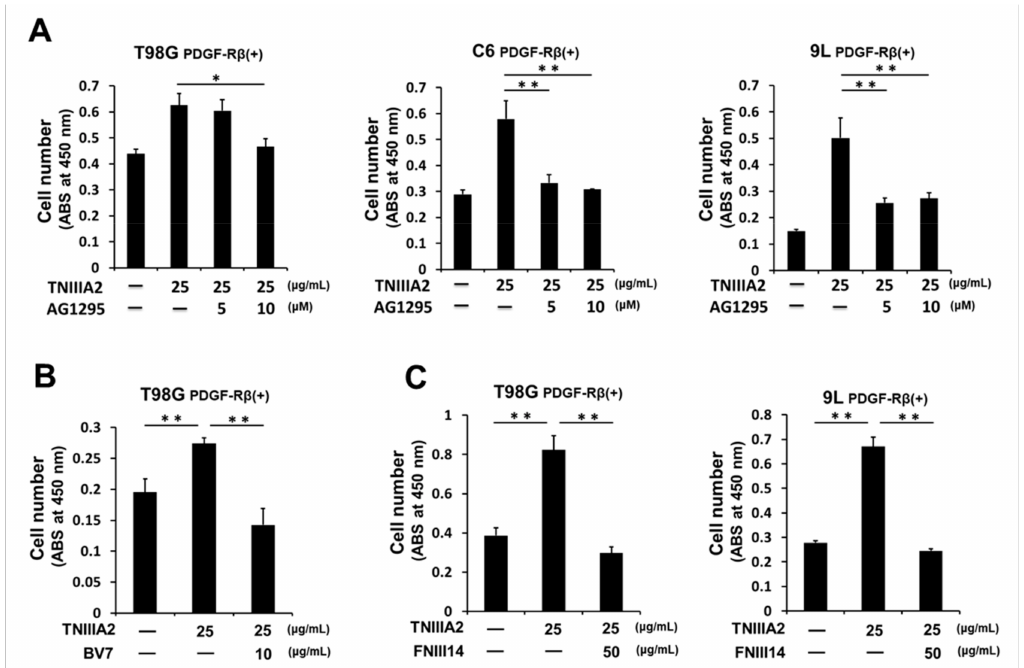
Figure 2. TNIIIA2 potentiates PDGF-dependent GBM cell proliferation through stimulation of PDGF-R tyrosine kinase activity by β 1-integrin activation. E ff ects of ( A ) AG1295, PDGF-R kinase inhibitor, ( B ) BV7, β 1-integrin neutralizing mAb, and ( C ) peptide FNIII14, a β 1-integrin inactivator on GBM cell proliferation potentiated by TNIIIA2, were examined for cells adhering to the fibronectin substrate, evaluated by WST-8 assay. Data represent the mean ± standard deviation of triplicate determinations, * p < 0.05, ** p <